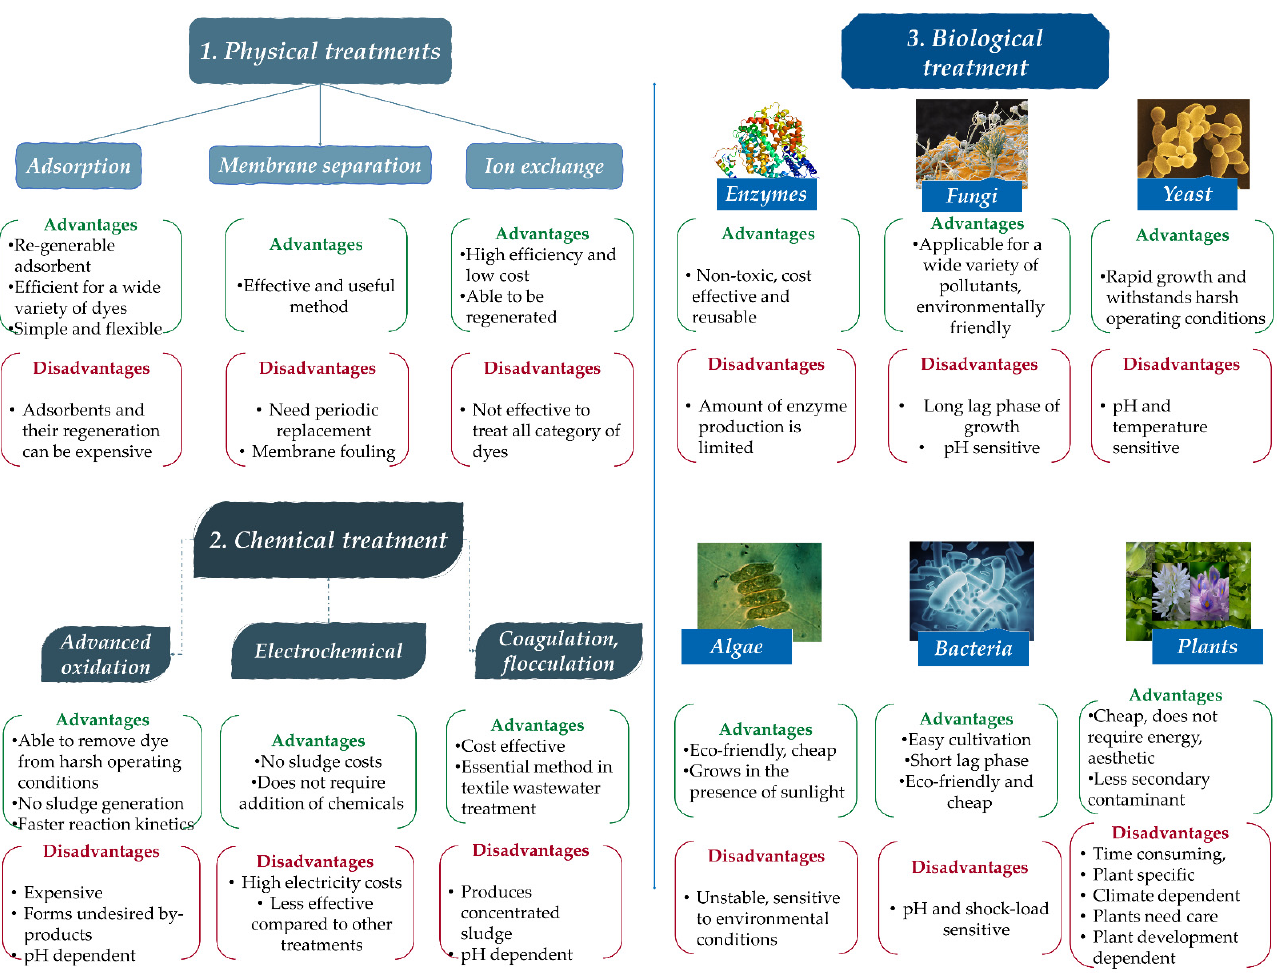
Figure 3. Dye removing methods and their advantages/disadvantages [89].